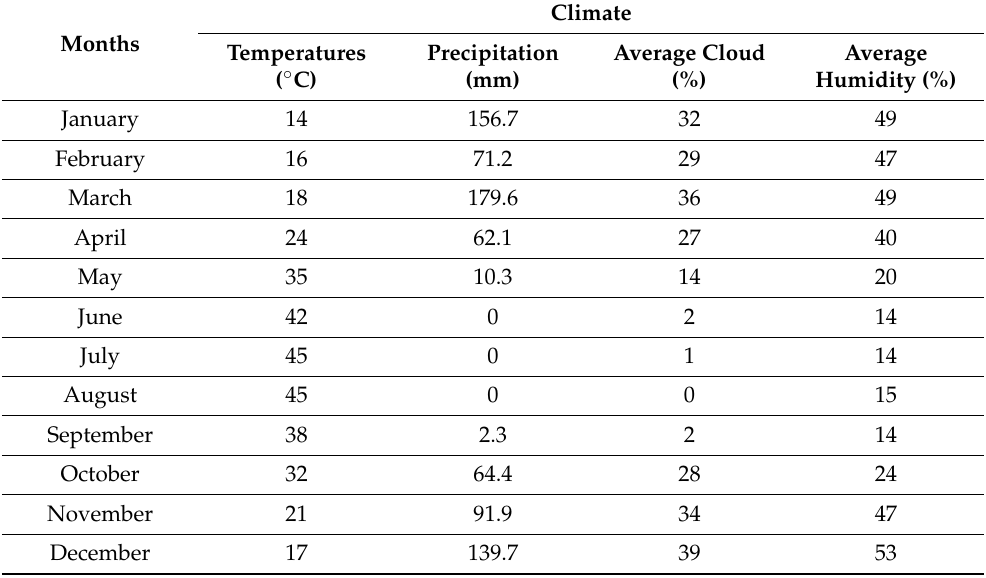
Table 1. Average monthly climate at the test site.